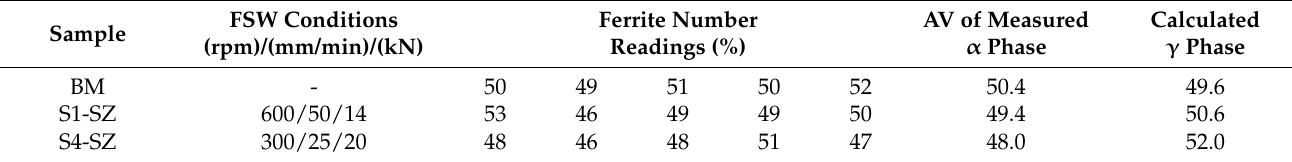
Table 5. Ferrite Number Readings (%) for the 2205 DSS BM and the SZ of the Butt Welded Joints.